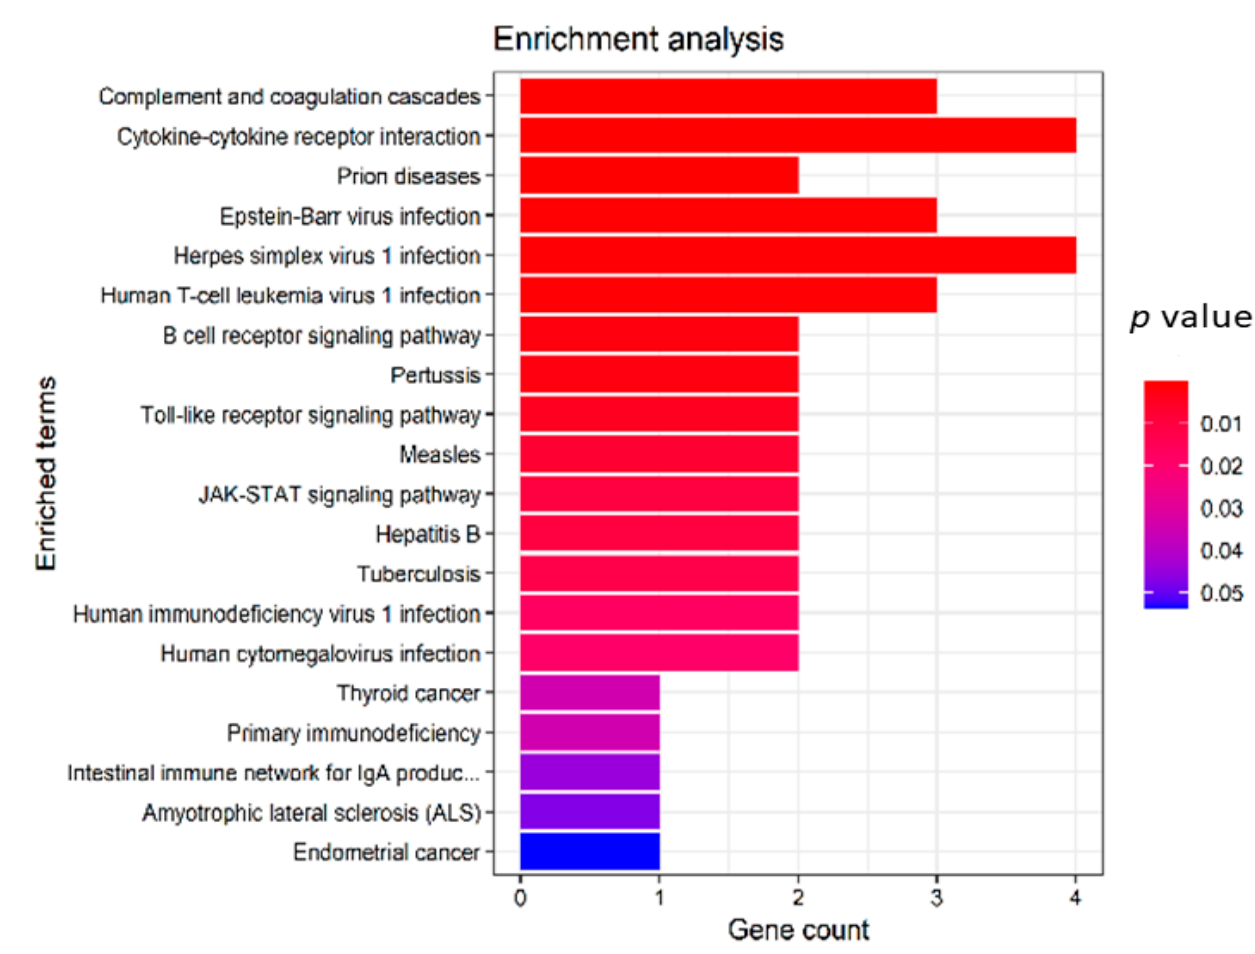
Figure 5. Enrichment analysis of gene signatures. Legend represents the p values associated with the pathways.